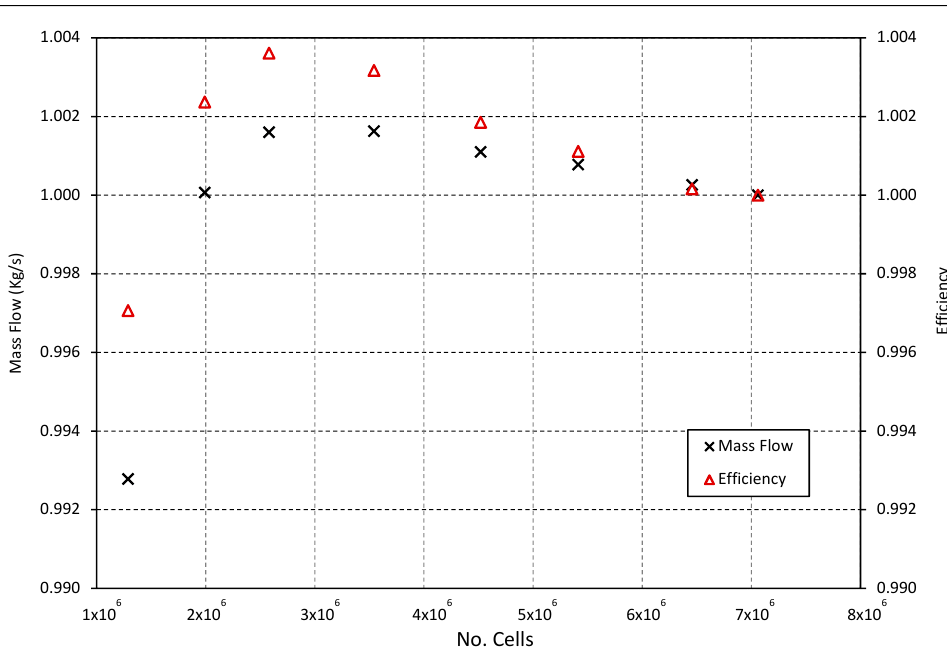
Figure 4. Computational domain set-up.